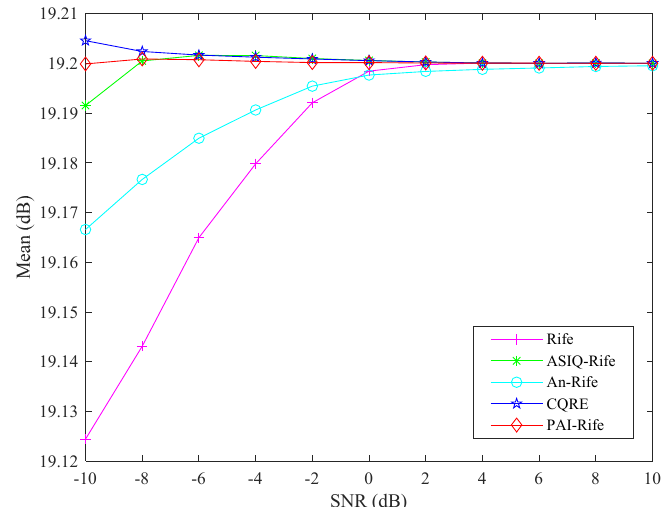
Figure 6. Mean of PAI − Rife and other Rife algorithms at different SNRs.